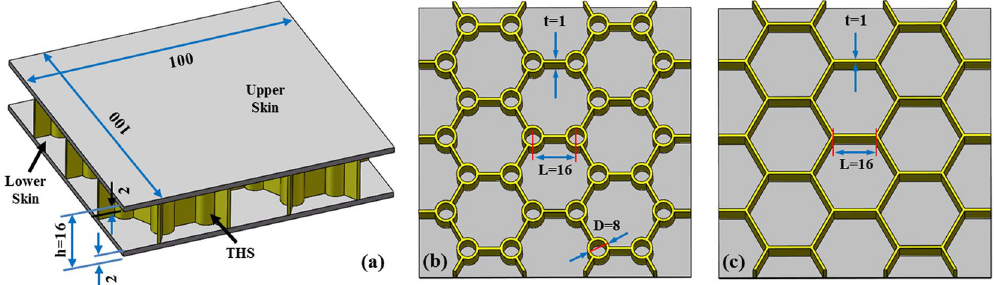
Figure 3. Dimensions and structures of the sandwich plates. ( a ) Overall dimensions. ( b ) core structure of a BEP. ( c ) core structure of a HP. In the figure, L denotes the length of the honeycomb walls or the distance between the central points in adjacent trabeculae, D denotes the external diameter of the trabeculae, the thickness (t) of the honeycomb walls is equal to that of the trabeculae, and the unit is mm.